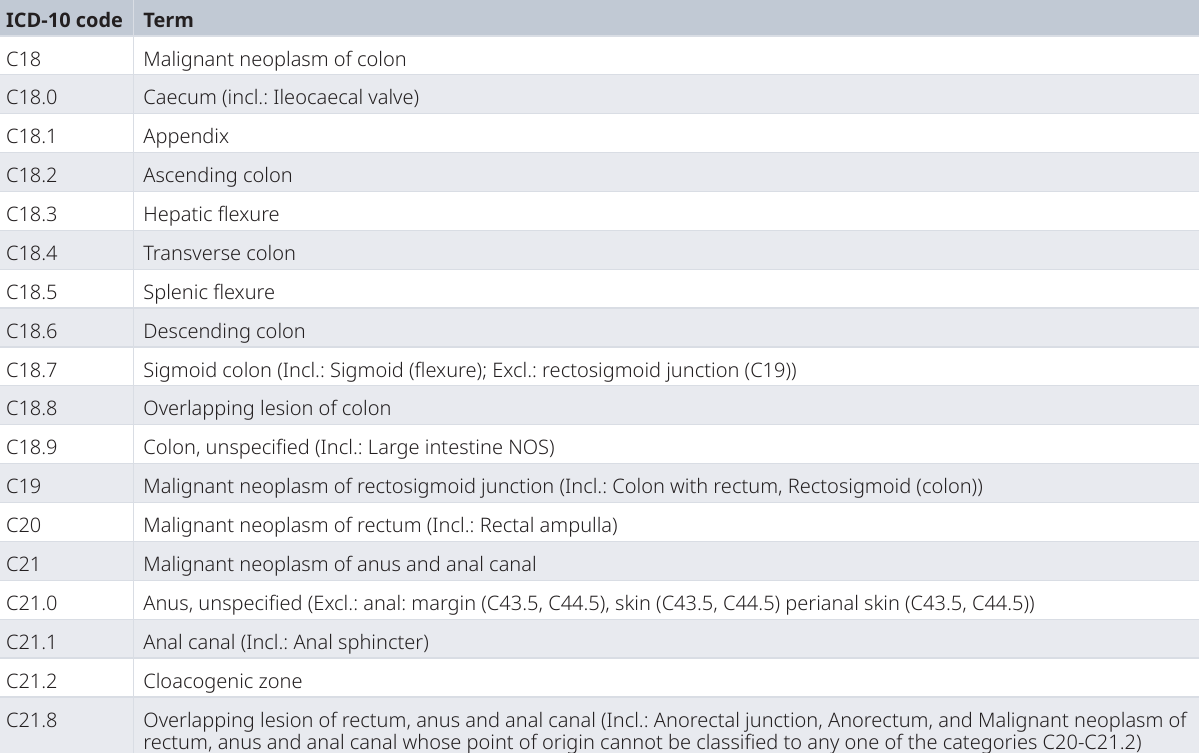
Table 2. Clinical codes relating to colorectal cancer from NCRAS. ICD-10 code